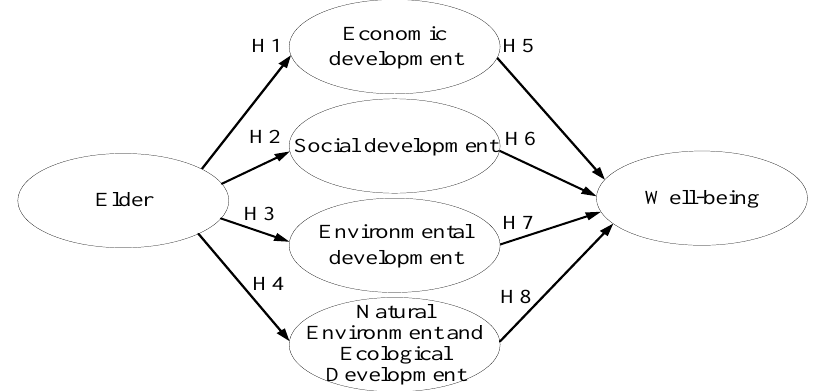
Figure 1. Research framework.